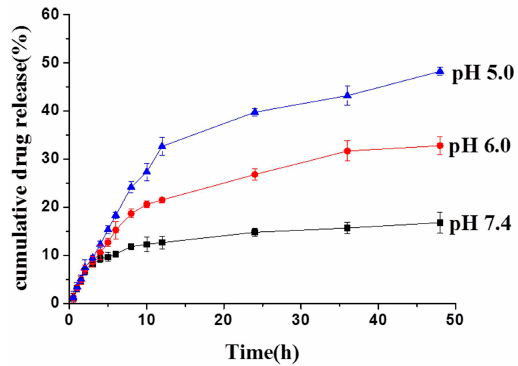
Figure 3. pH-dependent PTX release from mPEG-PCL-Ace-PTX 5 micelles. The data were presented as mean ± standard deviation ( n = 3).